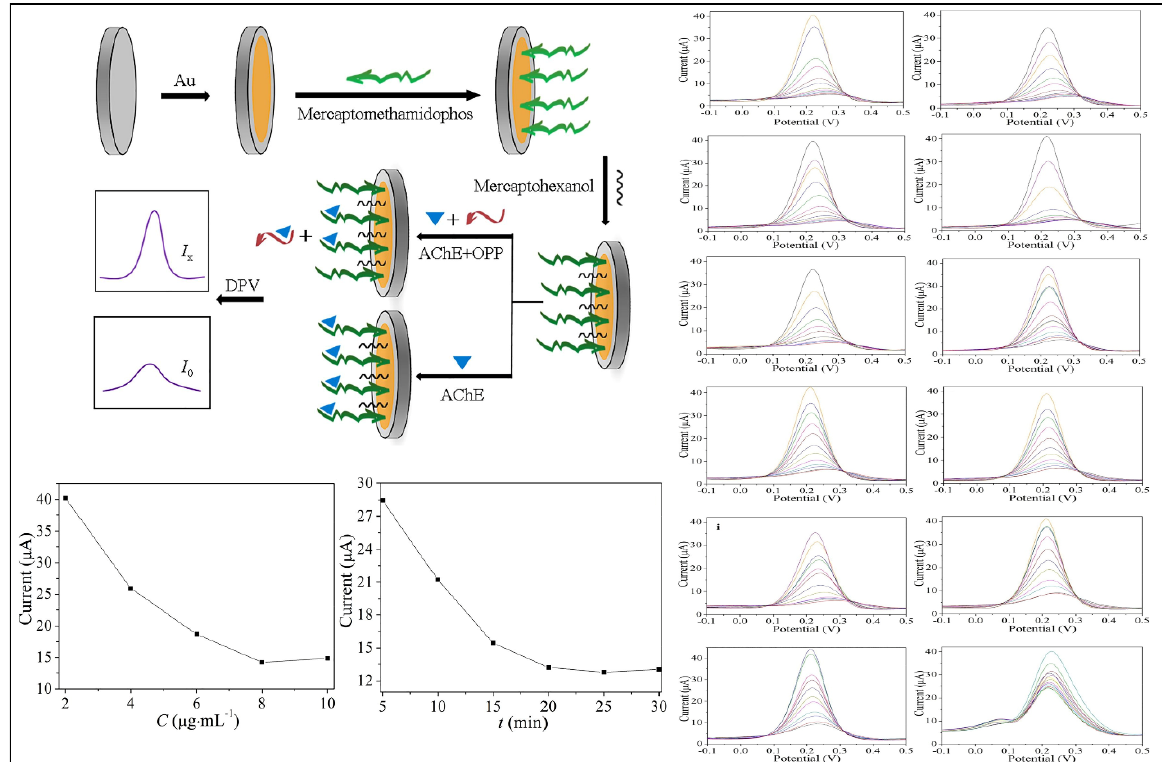
Figure 12. Detection illustration of nanogold/mercaptomethamidophos electrochemical biosensor, AChE concentration added, incubation time, and differential pulse voltammetry of the 12 pesticides detections. Reprinted with permission from Zhao et al. [24]. Copyright 2021, Elsevier.